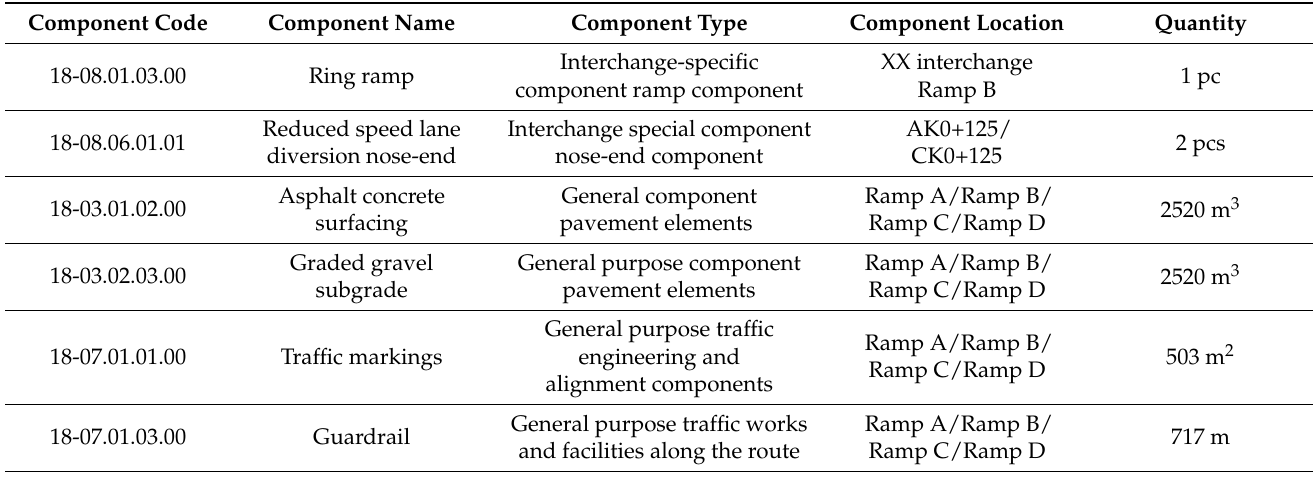
Table 10. Quantities of interchange BIM